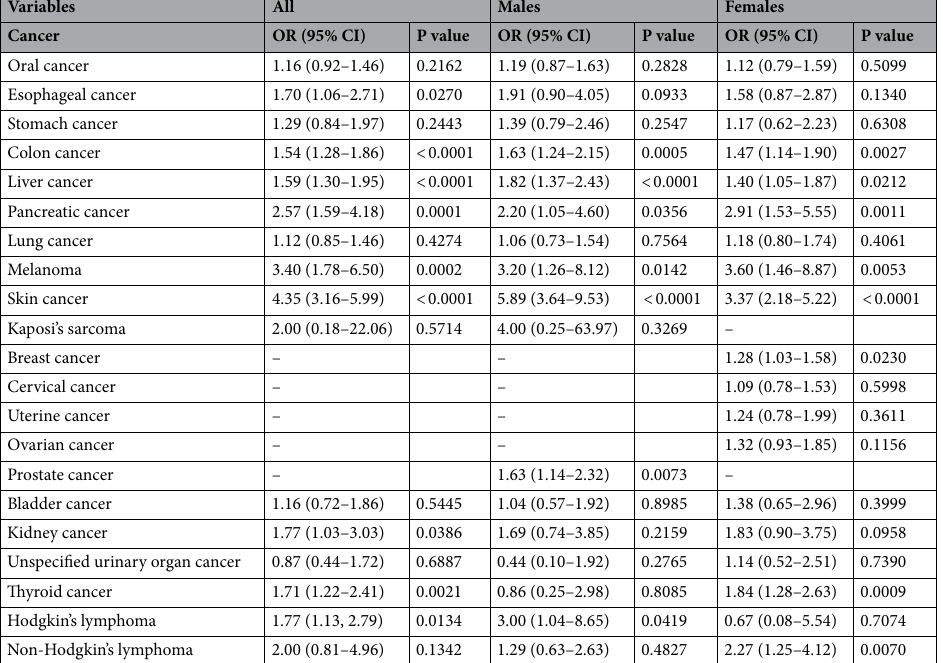
Table 3. Odd ratio of specific cancers in patients with keloids, stratified by gender. OR odd ratio, 95% CI 95% confidence